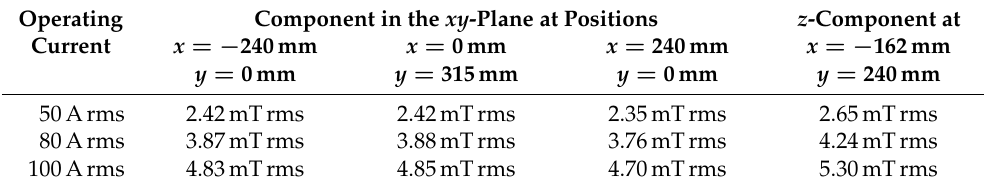
Table 7. Maximum magnetic flux densities of the charging system at different operating currents in the resonant circuit of the ground assembly calculated from the measured